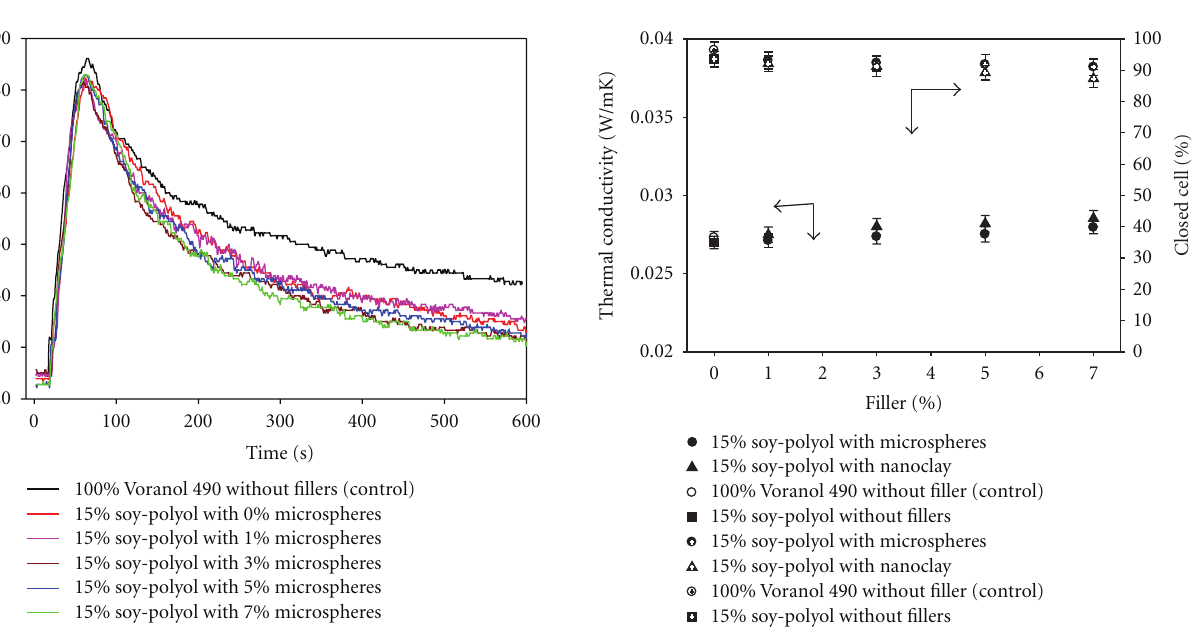
Figure 8: The e ff ect of microspheres and nanoclay on thermal conductivity and closed cell percentage of SBO